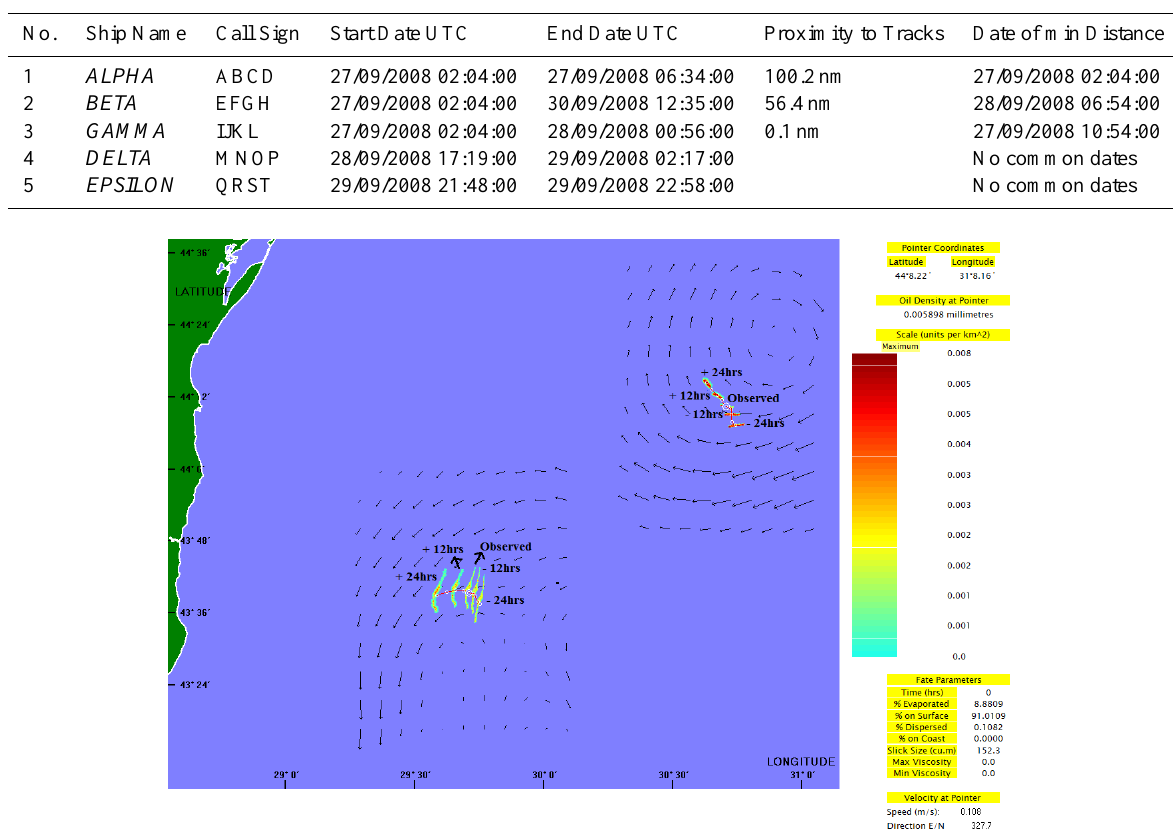
Fig. 9. Forecasts and hindcasts each for 24h of the two slicks detected in Fig.